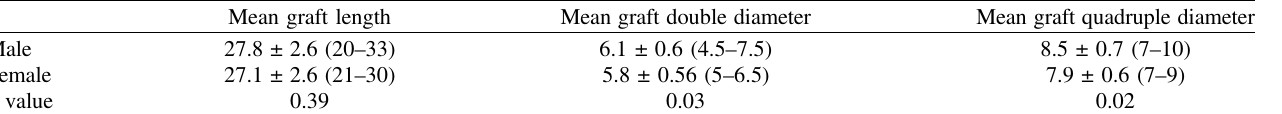
Table 2. Graft parameters in